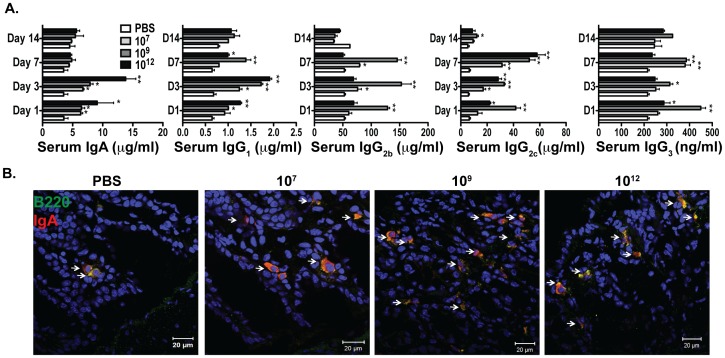
Humoral immune responses elicited by L. gasseri expressing PA-DCpep.C57BL/6 mice were orally gavaged with increasing doses of L. gasseri expressing PA-DCpep (107, 109 and 1012 CFU) or PBS; serum was isolated after days 1, 3, 7 and 14, and ELISAs were performed to measure the secretion of IgA, IgG1, IgG2b, IgG2c and IgG3 (A). Data are representative of two independent experiments. Error bars represent ±SEM. *P<0.05 and **P<0.01 compared with PBS. (B) C57BL/6 mice were orally gavaged with increasing doses of L. gasseri expressing PA-DCpep (107, 109 and 1012 CFU) or PBS; colonic sections were stained with B220 (green) and IgA (red) antibodies, and visualized using confocal microscopy.